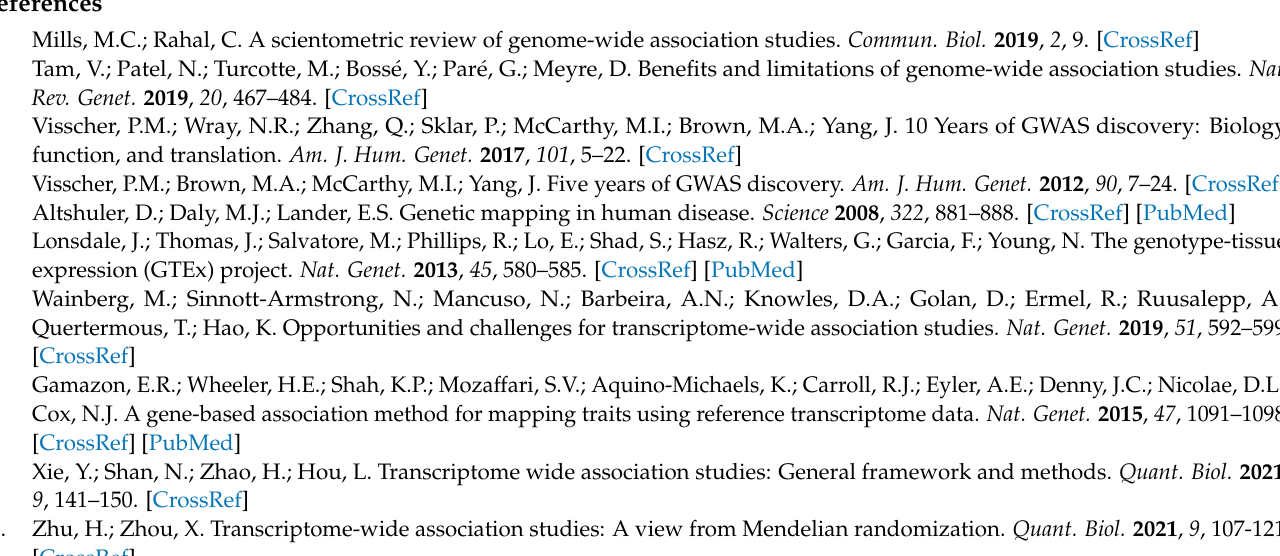
Table S1: the prevalence (%) of self-reported health conditions among 142,202 UKBB participants with available genotypic and CPD data. Table S2: the frequency of alcohol and cannabis consumption among 142,202 UKBB participants with available genotypic and CPD data. Supplementary file 1: a comparison of brain tissue-specific genes between the associations with nicotine dependence (e.g., CPD) from both the UKBB cohort and GSCAN cohort. Supplementary file 2: full output of pathway enrichment analysis for each our detected meta-pattern